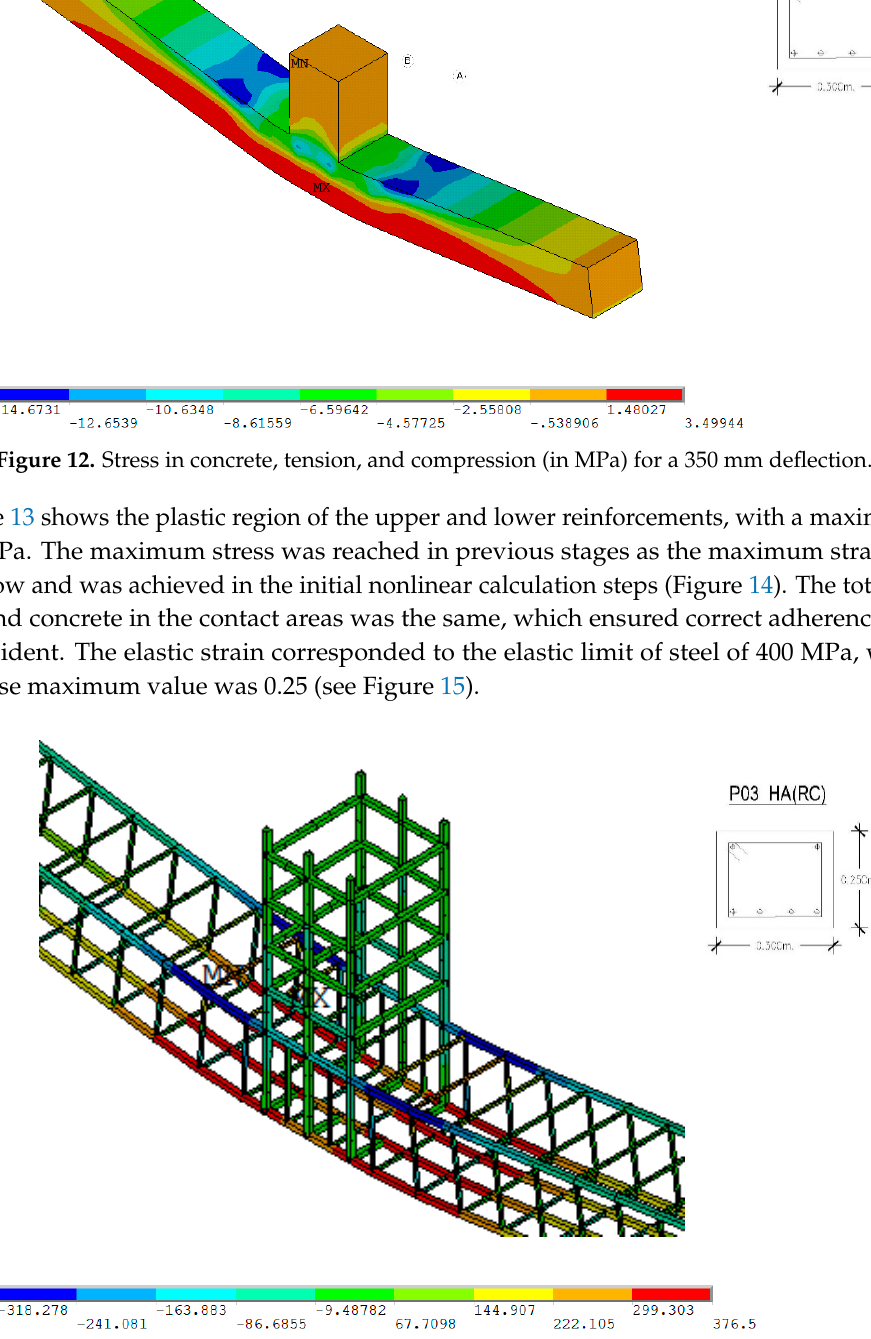
Figure 13. Stress in reinforcements, tension, and compression (in MPa) for a 350 mm deflection.